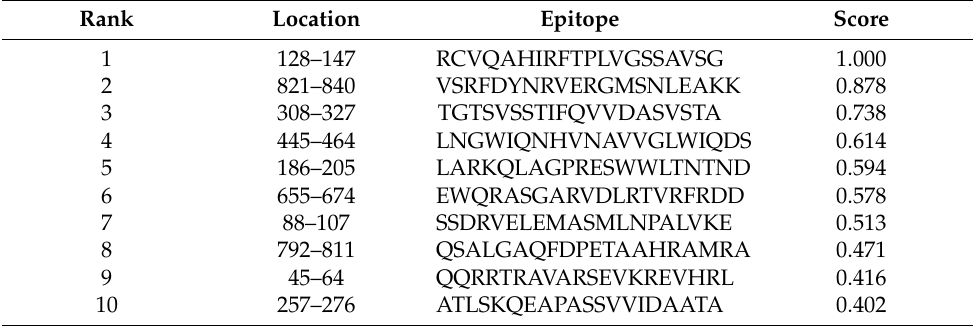
Table 3. Epitopes predicted inside the Cap protein.